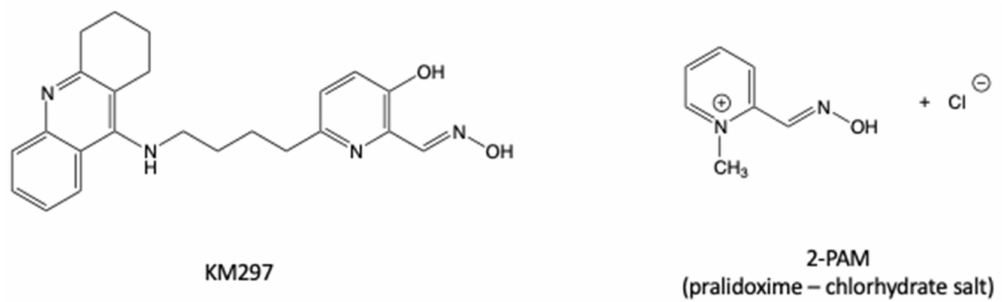
Figure 1. Chemical structures of the oximes used in this study, the reference oxime 2-PAM, and the novel α -hydroxypyridine oxime